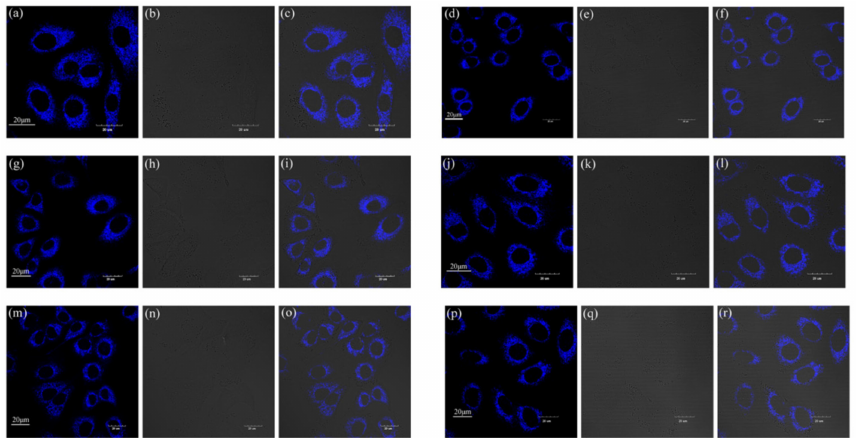
Figure 8. The imaging figures of A549 cells co-cultured with compounds ( a ) 1 , ( d ) 2 , ( g ) 3 , ( j ) 4 , ( m ) 5 , ( p ), 6 (10 µ M) for 30 min. The bright-field images of A549 cells co-cultured with ( b ) 1 , ( e ) 2 , ( h ) 3 , ( k ) 4 , ( n ) 5 , ( q ) 6 . The merged images co-cultured with ( c ) 1 , ( f ) 2 , ( i ) 3 , ( l ) 4 , ( o ) 5 , ( r ) 6 . An excitation wavelength of 405 nm was selected for the